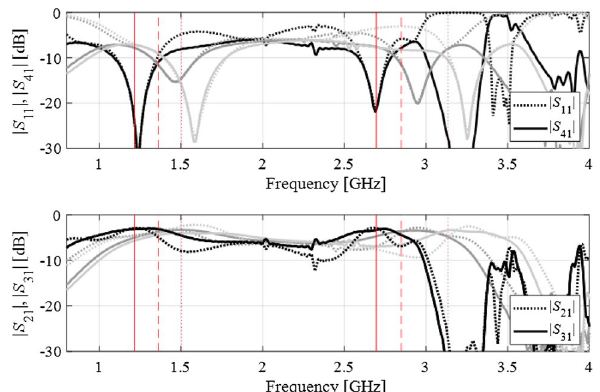
Figure 12. Dual-band branch-line coupler: scattering parameters at the three intermediate designs, marked using the light-gray, dark-gray, and black colors (optimum), along with the corresponding target frequencies. For the sake of clarity, the matching/isolation characteristics are shown separate from the transmission characteristics.